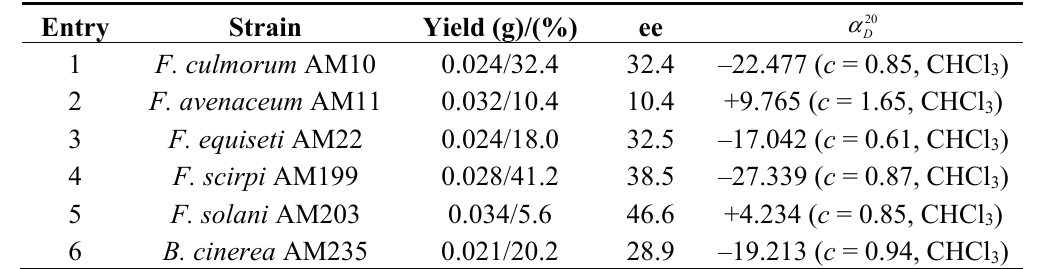
Table 3. Data on hydroxylactone 7a obtained during preparative biotransformations of lactone 4a . Entry